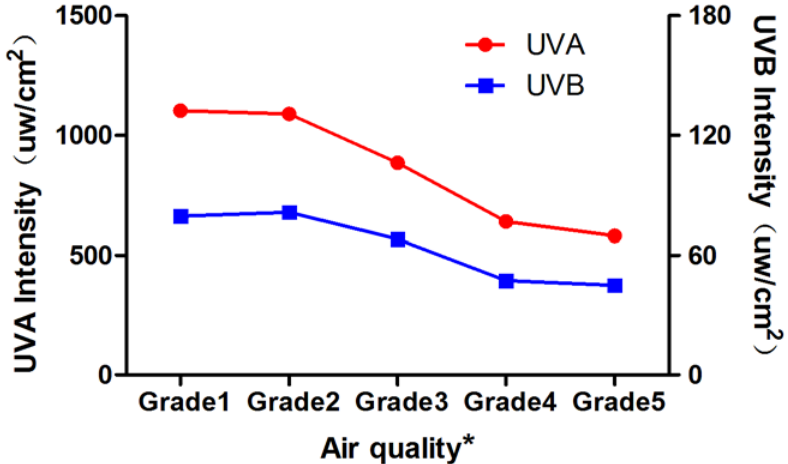
doi:10.1371/journal.pone.0124758.g006